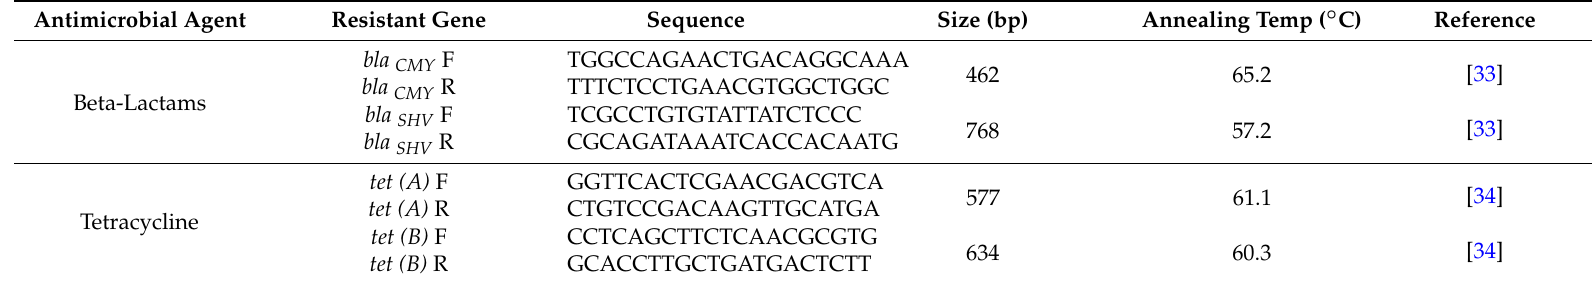
Table 5. Beta-lactams- and tetracycline-resistant genes and primer sequences used for polymerase chain